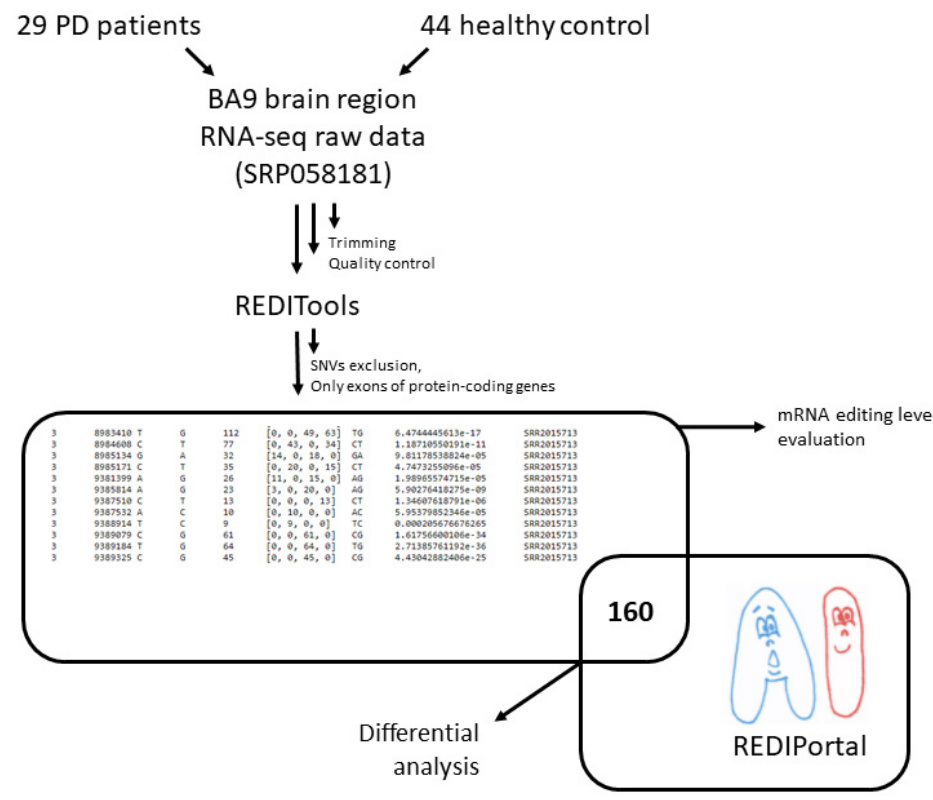
Figure 1. The workflow of data preprocessing, differential RNA edited site analysis, and RNA editing level evaluation.